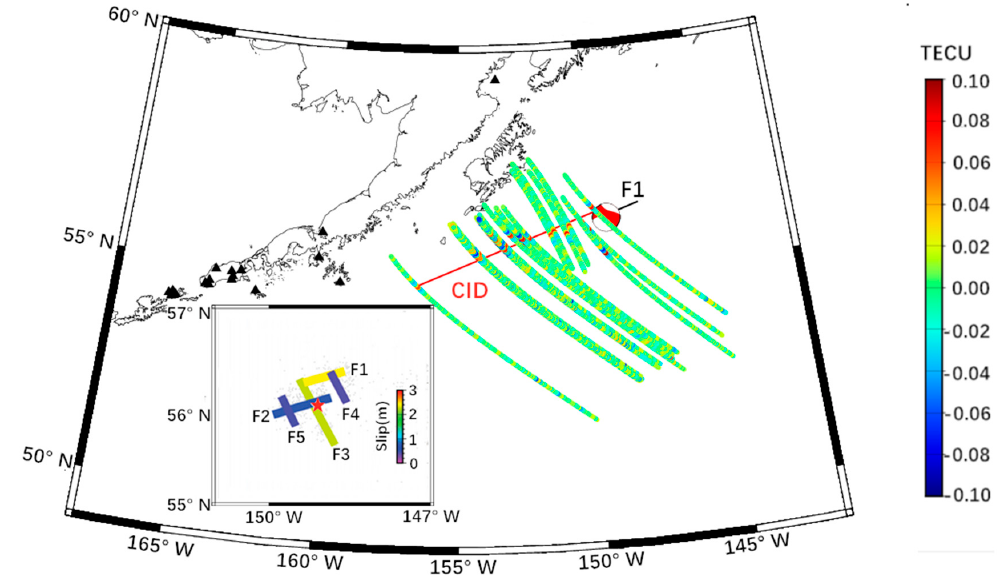
Figure 7. SIPs of the detected CIDs are distributed in the southwest direction of the epicenter (UTC 9:00–10:00). The color depth represents the amplitude of the ionosphere disturbance. The red line represents the direction of the CID and the black line represents the direction of the F1. The subgraph shows the inverted uniform slip model for the Alaska earthquake, the color depth represents the amount of sliding, and the star indicates the epicenter.